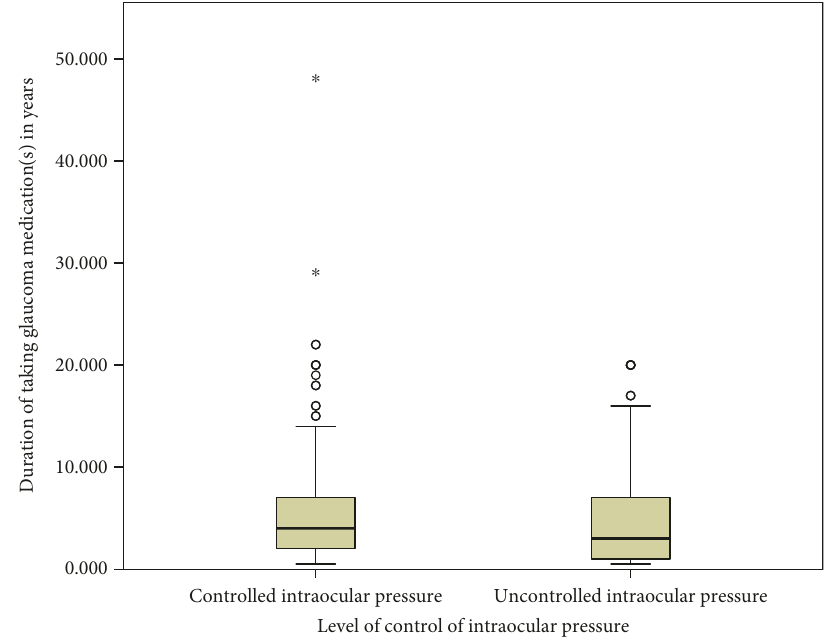
Figure 1: Level of intraocular pressure by the duration of taking glaucoma medications in Menelik II Hospital, 2015. ∗